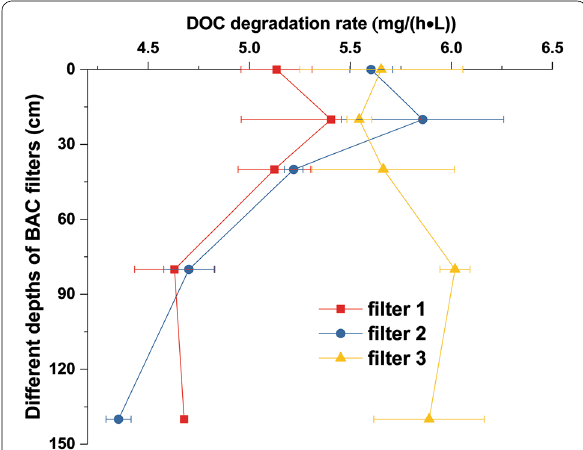
Fig. 3 Microbial DOC degradation rates as a function of depth in the BAC filters. Depth 0 corresponds to the top of the filter bed. Data depict means and standard deviations of three parallel incubations. Filters 1 and 2 are filled with granular activated carbon whereas filter 3 is filled with extruded activated